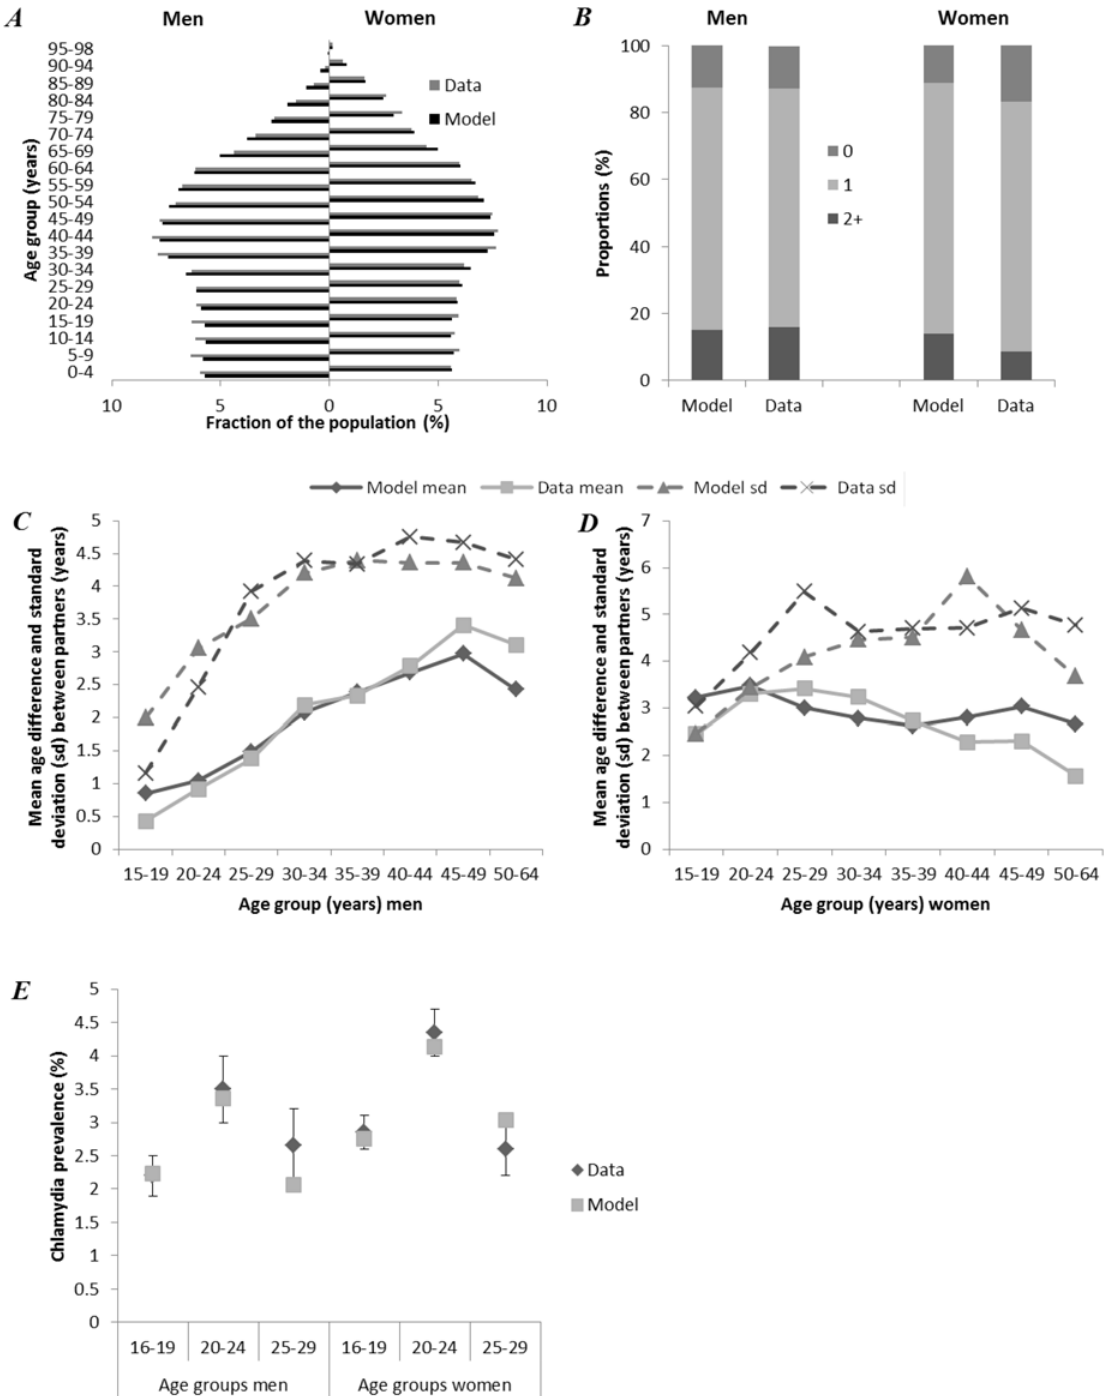
Figure 1. Comparison of the model predictions with data of population composition, sexual behavior and chlamydia prevalence. Modeled population composition per age group, compared to data of Statistics Netherlands [25] (A) . Modeled number of partners in the last 6 months in men and women aged 20 – 64 years, compared to data of 19 – 64 years old in Rutgers WPF [27,28] (B) . Mean and standard deviations (sd) of age differences in relationships, reported by male respondents (C) and female respondents (D) . Modeled chlamydia prevalence of 15 – 29 years old compared to the data of